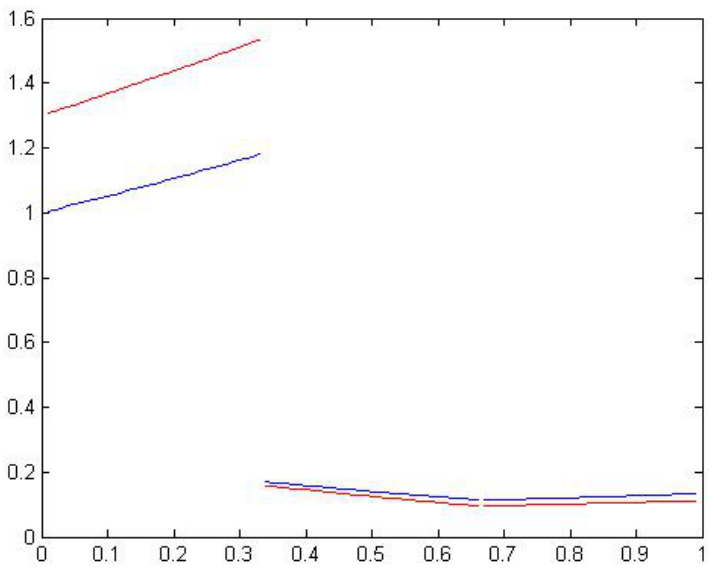
Figure 1. The blue line denotes the solution of Equation (27) and the red line denotes the corresponding perturbation